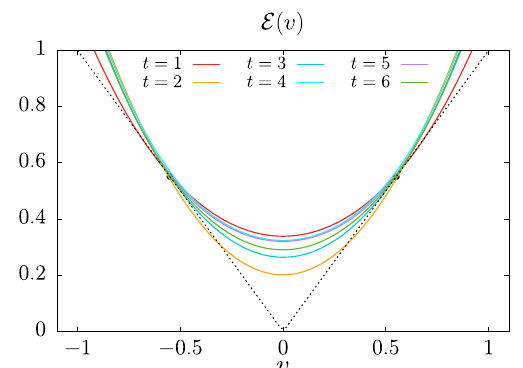
FIG. 17. Numerical calculations of E ð v Þ for Floquet evolution with the sinusoidally varying h